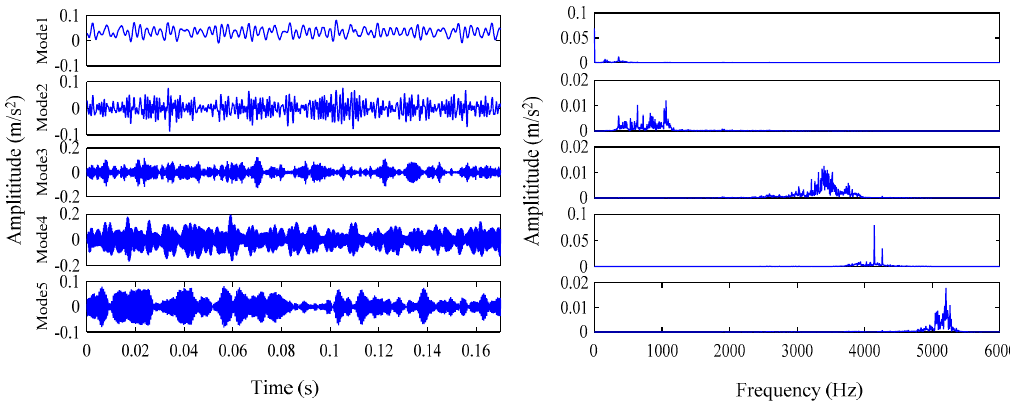
Figure 30. Decomposition results and corresponding frequency spectrum of the IMFs for challenging signal with VMD.